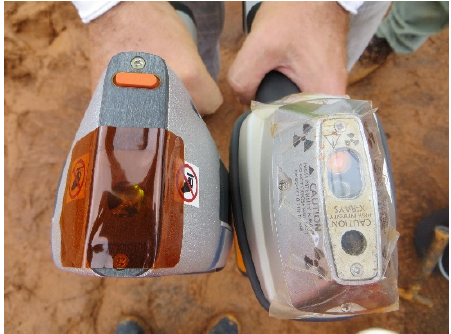
Figure 1. Protective tape, Kapton on the left, 3M scotch on the right.